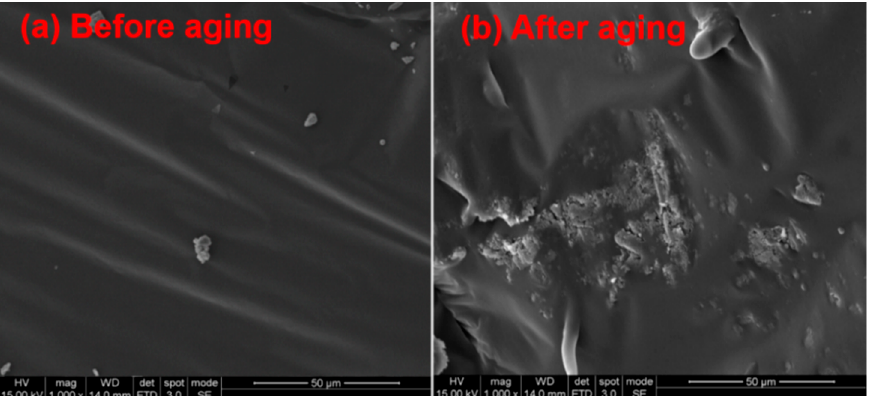
Materials 2020 , 13 , x FOR PEER REVIEW Figure 7. SEM images of asphalt ( a ) before and ( b ) after the isothermal-oxidative aging.